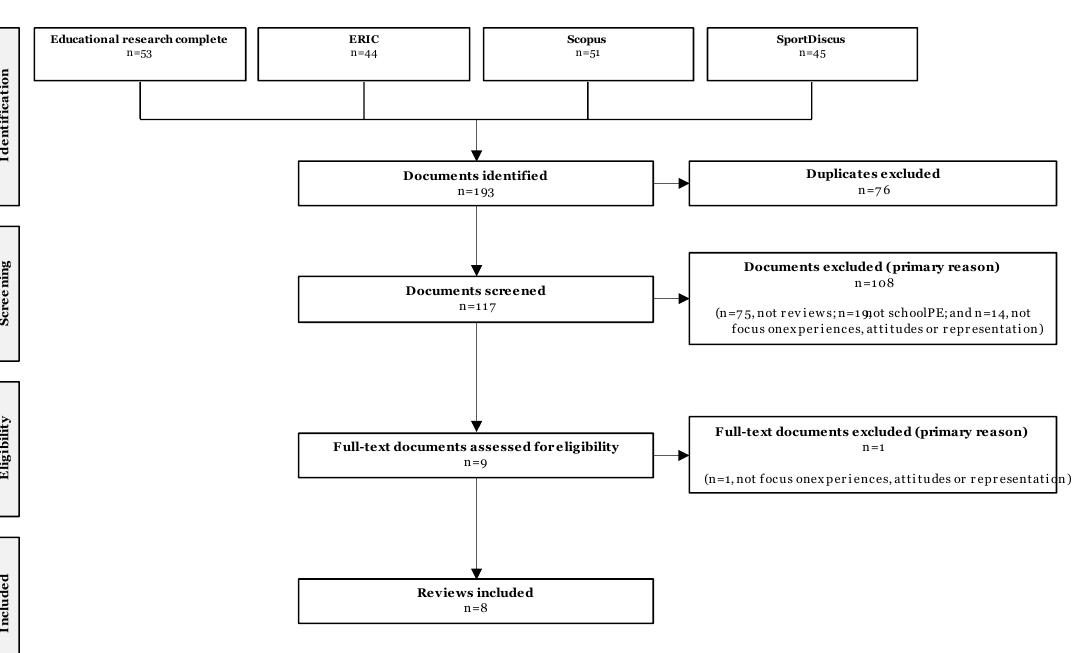
Figure 1. The PRISMA